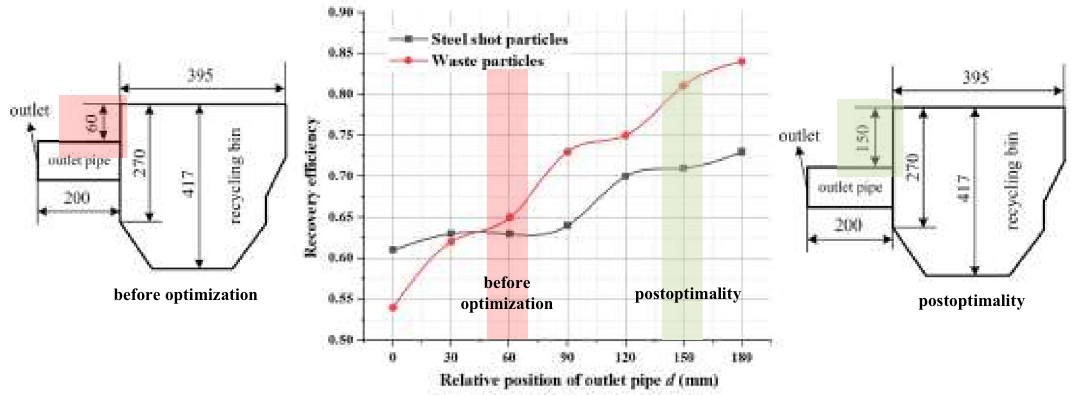
Figure 18. Effect of outlet position on the recovery efficiency of projectile particles and waste